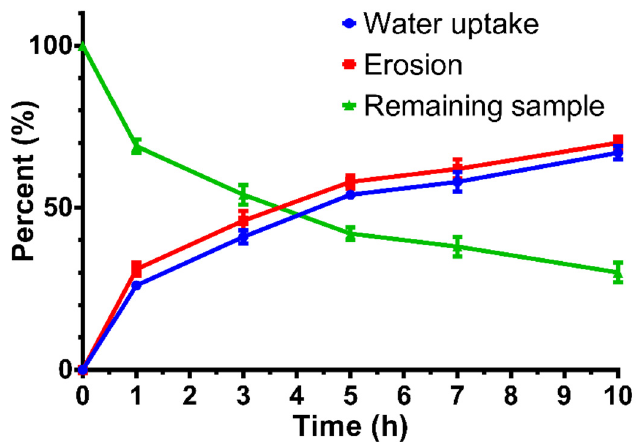
Figure 9. Water uptake, erosion, and remaining sample (%) vs. time (h) curve of the V2 compositions. Bars represent mean ± S.D. (n = 3).